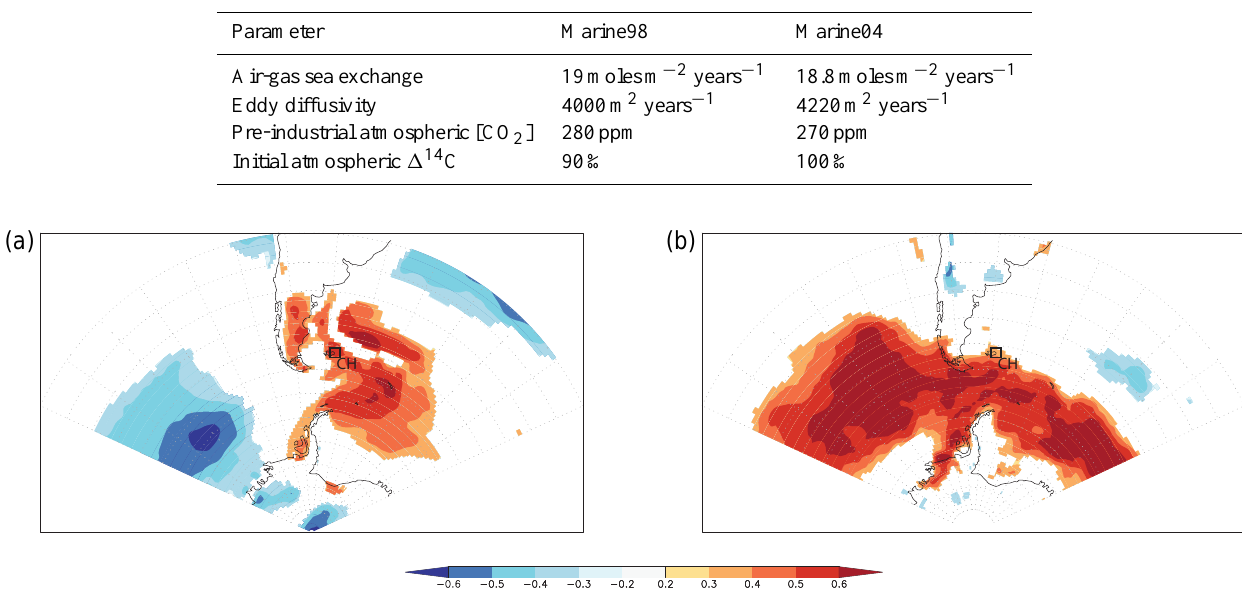
Table 2. Box diffusion model parameters for Marine98 (Bond et al., 2001; Turney et al., 2005) vs. Marine04 (Hughen et al., 2004).